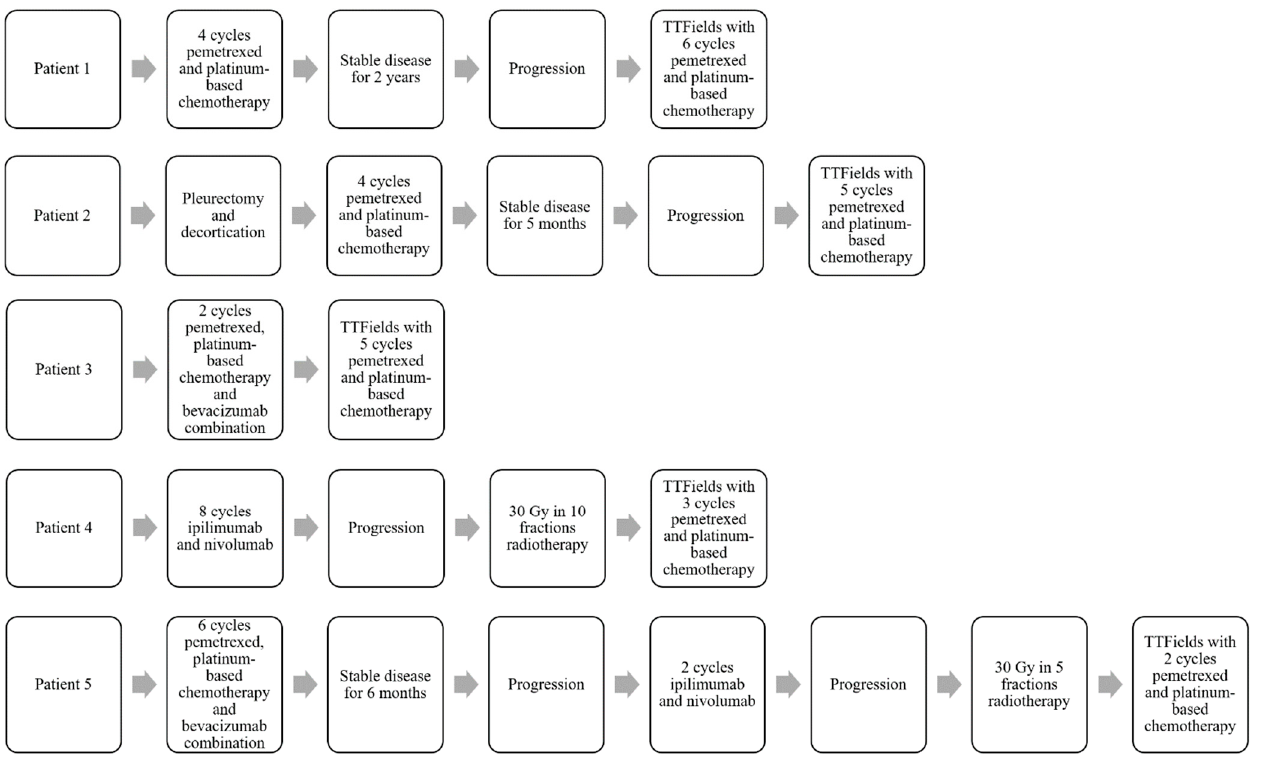
Figure 1. Pre-TTFields treatment details. Table 1. Patient and disease characteristics.